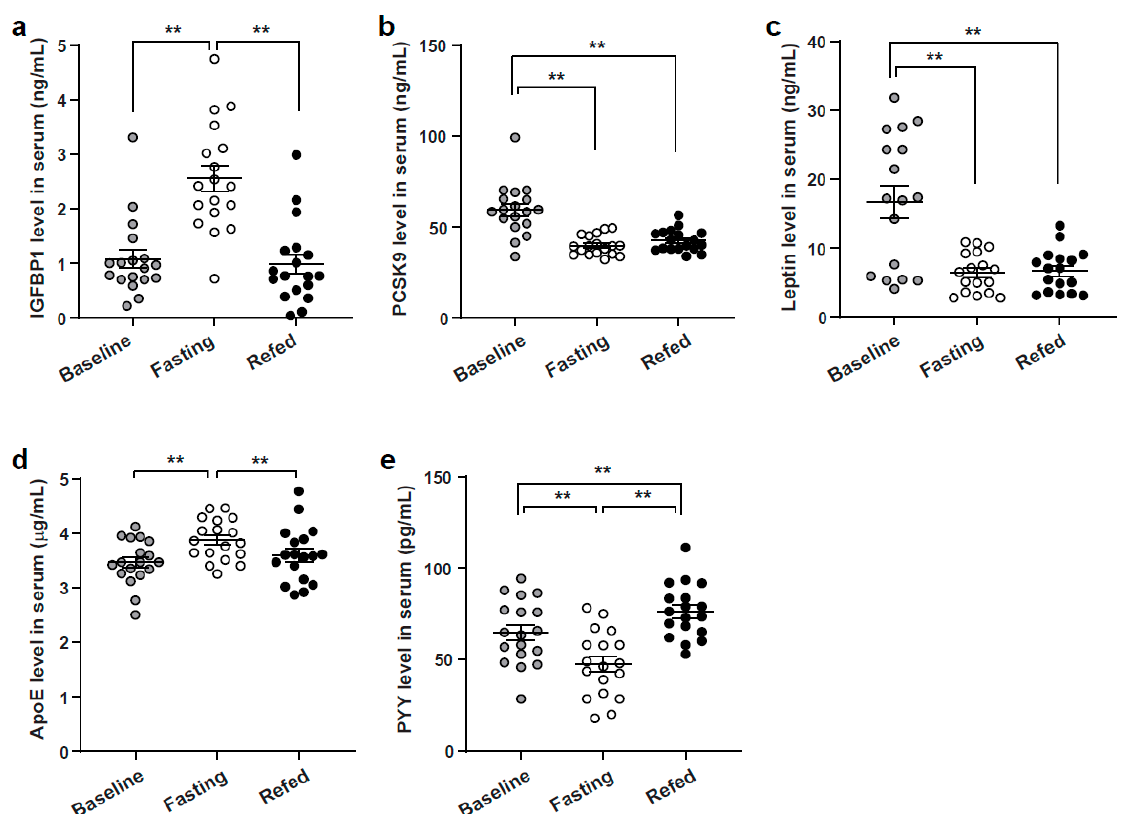
Figure 3. Verify the VIP SOMAscan results by ELISA. ( a ) IGFBP1, ( b ) PCSK9, ( c ) Leptin, ( d ) ApoE, and ( e ) PYY level were measured by ELISA using serum collected from three metabolic conditions ( n = 18). Paired t test; ** p < 0.01. VIP, Variables of importance in prediction; IGFBP1, Insulin-like growth factor-binding protein 1; PCSK9, Proprotein convertase subtilisin/kexin 9; ApoE, Apolipoprotein E; PYY, Peptide tyrosine-tyrosine.